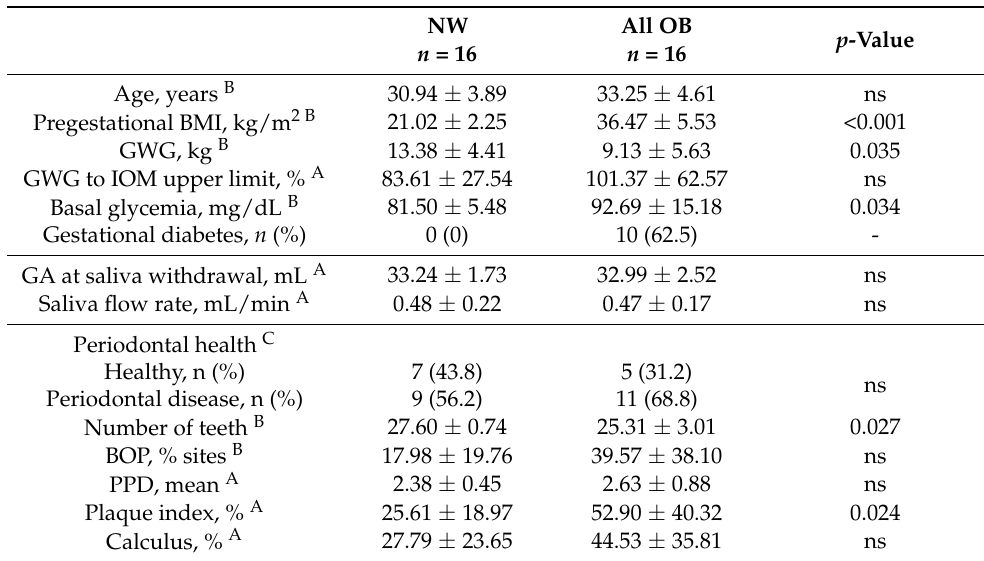
Table 2. Maternal and periodontal health